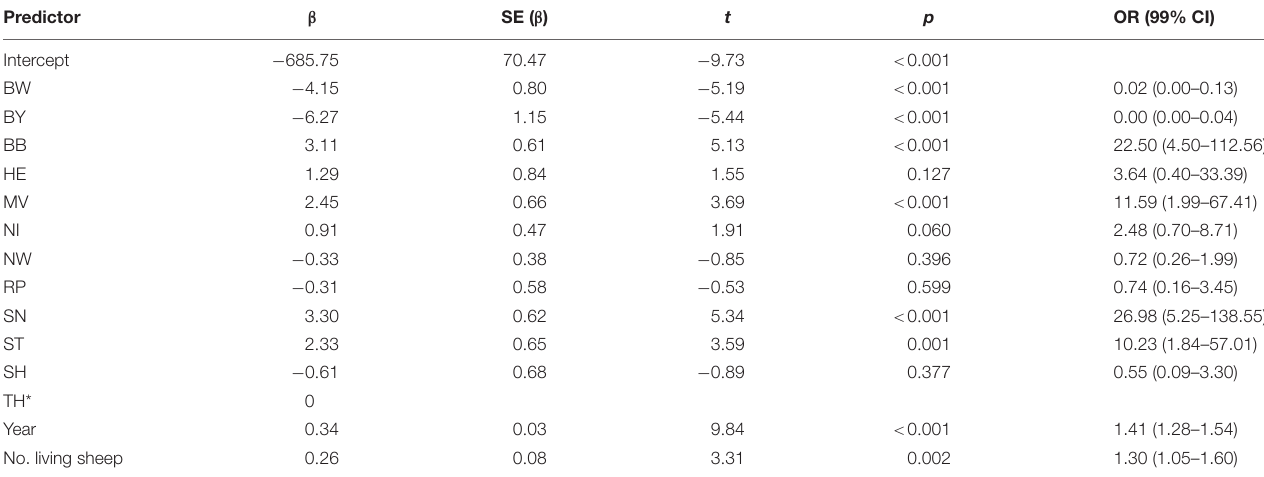
TABLE 2 | The best model ( (cid:49) AIC c < 2) output of the effects of state, year, and number of living sheep ( × 10,000 individuals) on the number of sheep killed by wolves in Germany. Predictor β SE ( β